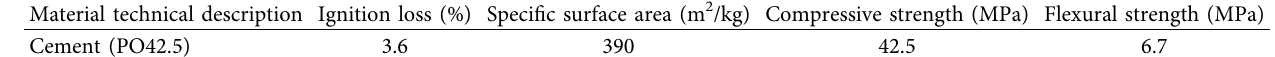
Table 2: Material technical description of cement.